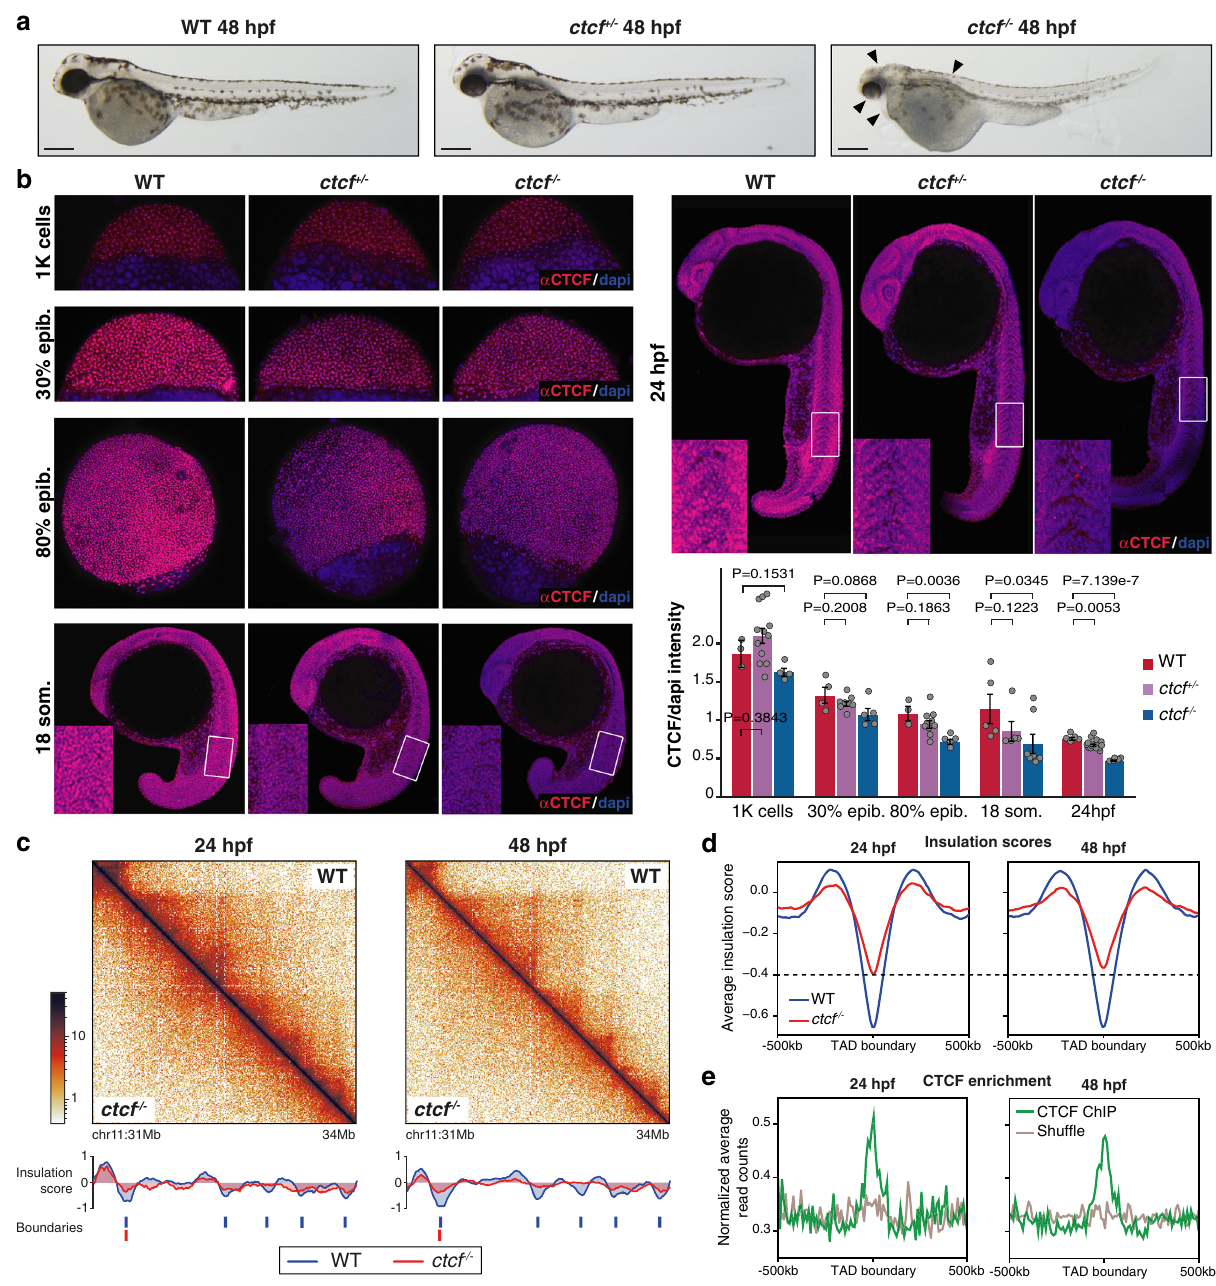
Fig. 1 Knockout of ctcf in zebra fi sh embryos disrupts chromatin structure. a Pictures of wild-type (WT), ctcf + / − and ctcf − / − zebra fi sh embryos at 48 h post fertilization (hpf) showing homozygous mutant phenotypes, including the reduced size of head and eyes, heart edema, and defective pigmentation (arrow heads). Scale bars represent 250 μ m. b Whole-mount embryo immuno fl uorescence of CTCF (red) and dapi (blue) in WT, ctcf + / − and ctcf − / − zebra fi sh embryos at the stages of 1000 cells (1 K cells), 30% of epiboly (30% epib.), 80% of epiboly (80% epib.), 18 somites (18 som.) and 24 hpf showing the maternal contribution of CTCF protein. Relative quanti fi cation of CTCF/dapi signal with average values ± standard error is shown. Statistical signi fi cance was measured using a two-sided Student ’ s t test. The number of embryos for WT, ctcf + / − and ctcf − / − used for quanti fi cation are as follows: 1 K cells ( n = 3, n = 12, n = 3); 30% epib. ( n = 4, n = 8, n = 5); 80% epib. ( n = 3, n = 10, n = 5); 18 som. ( n = 5, n = 5, n = 7) and 24 hpf ( n = 5, n = 17, n = 5). Source data are provided as a Source Data fi le. c HiC normalized contact maps at 10-kb resolution from WT and ctcf − / − zebra fi sh embryos at 24 and 48 hpf. A 3-Mb genomic region in chr11 is plotted, aligned with the insulation scores and the called topologically associating domain (TAD) boundaries. d Average insulation score pro fi les of WT and ctcf − / − zebra fi sh embryos at 24 and 48 hpf around the TAD boundaries called in the WT. e Average CTCF ChIP-seq signal around TAD boundaries (green) and a shuf fl e control (brown) in WT embryos at 24 and 48